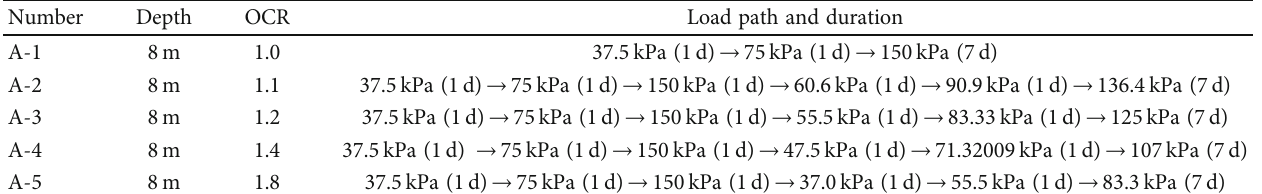
Table 1: One-dimensional consolidation experiment scheme.